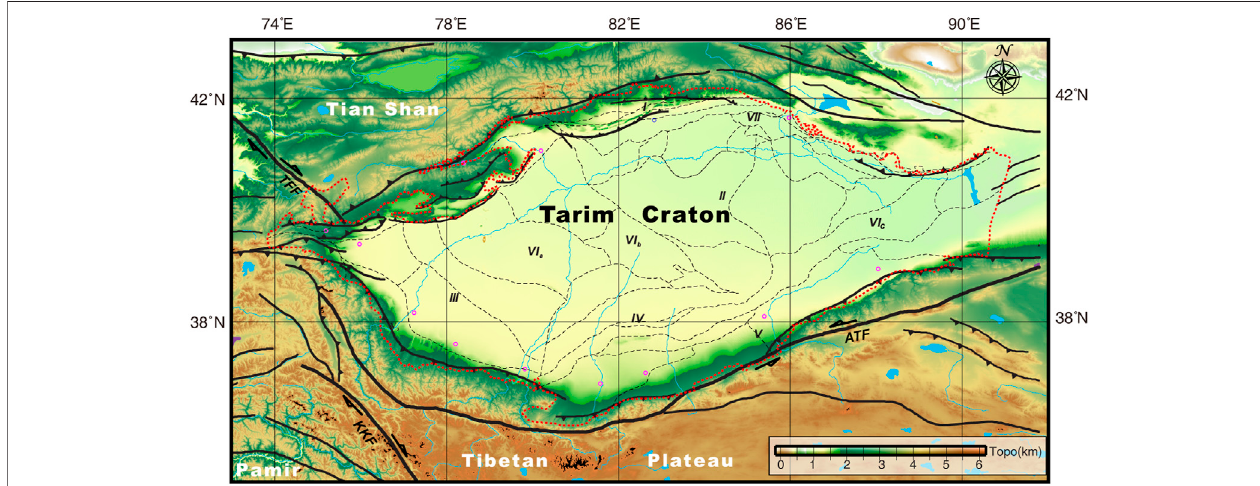
FIGURE1| TopographyandtectonicmapoftheTarimBasinanditsenvirons.ThereddashedlineoutlinestheTarimBasin,withinwhichthedashedblacklinesare the boundaries of subdomains corresponding to basinal structural units. The black lines represent major faults and sutures. Marks and abbreviations are as follows: Depression Domain: I: Kuche, II: Northern, III: Southwestern, IV: Tanggu, V: Southeastern; Uplift Domain: VI a : Bachu, VI b : Tazhong, VI c : Southeastern, VII: Tabei. ATF: Altyn-Tagh Fault, TFF: Talas-Fergana Fault, KF: Karakorum Fault. The tectonic units were modi fi ed from XJBGMR (Bureau of Geology and Mineral Resources of Xinjiang Province) (1993) and the topography is derived from the ETOPO1 model available from the NOAA database (http://www.ngdc.noaa.gov/mgg/global/global. html).